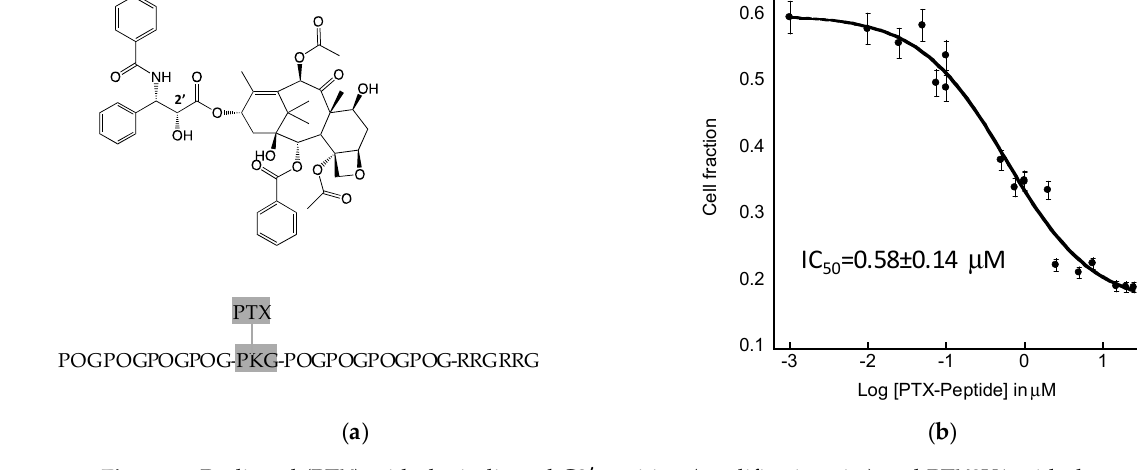
Figure 6. Paclitaxel (PTX) with the indicated C2 ′ position (modification site) and PTX8V1 with the indicated K14 conjugation site. Effect of PTX8V1 on FaDu cell survival ( a ). Error bars represent standard deviation calculated from at least 6 measurements. R 2 coefficient of the best fit is 0.975 ( b ).